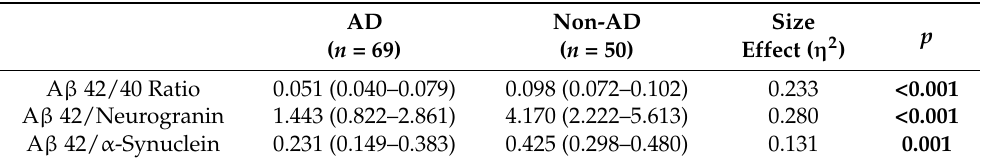
Table 2. A β 42/40, A β 42/Ng and A β 42/ α -Syn values in AD and n -AD patients.